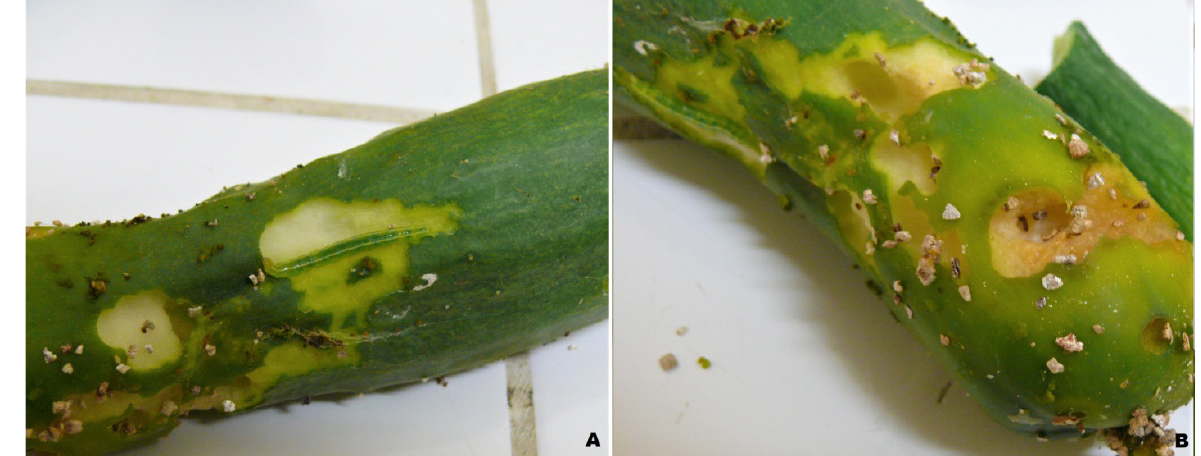
Fig 1 . Diaphania hyalinata larvae forming galleries inside the cucumber